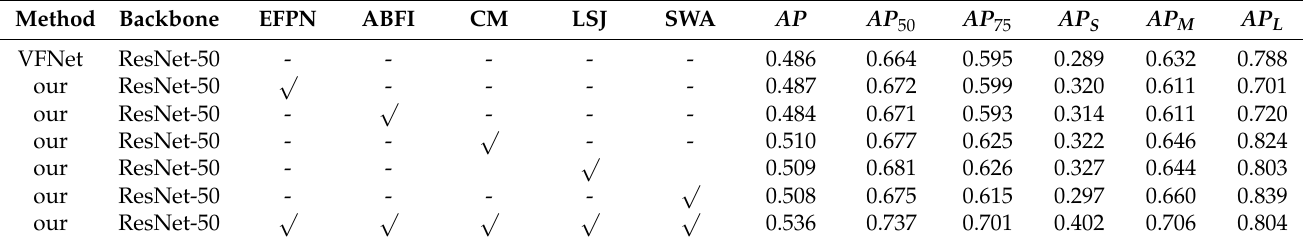
Table 1. Ablation experiment of the components on the DOTA v1.5